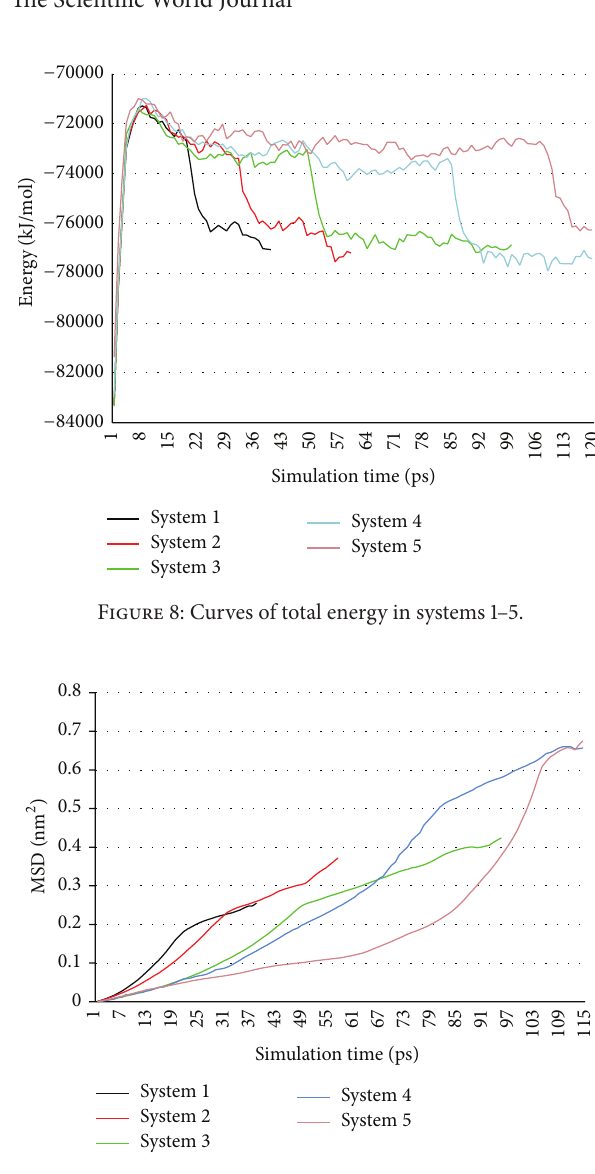
Figure 9: MSD curves of whole Fe atoms in systems 1–5.